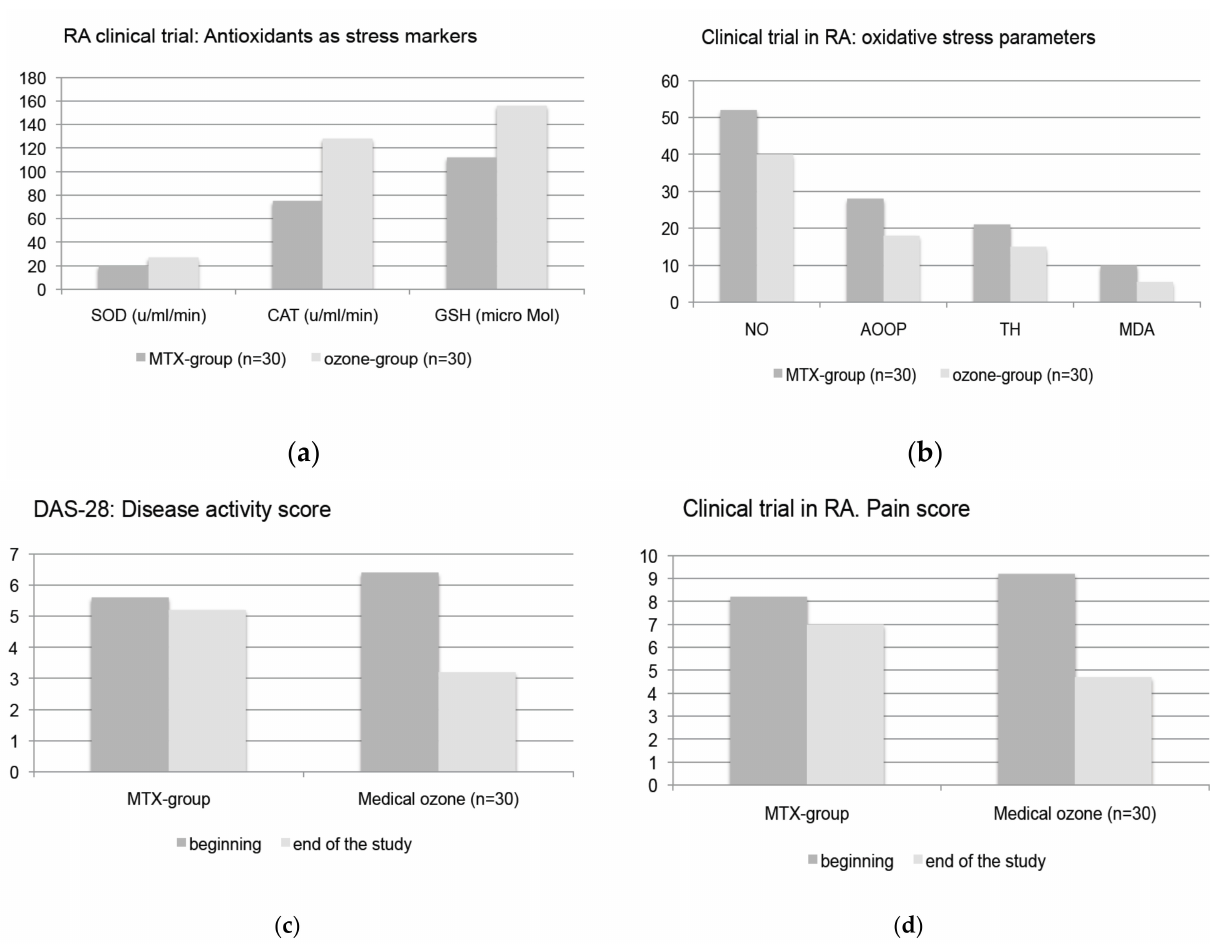
Figure 10. ( a ) Clinical trial in Rheumatoid arthritis RA ( n = 60) following 20 rectal ozone insufflations with ozone conc.: 25–40 µ g/mL and 5000–8000 µ g per treatment during 4 weeks. MTX-group ( n = 30): basic therapy MTX+Ibuprophen+Folic acid. Ozone-group ( n = 30): basics as MTX-group plus ozone rectally. SOD: superoxide dismutase, CAT: catalase, GSH: reduced glutathione [26]. ( b ). Oxidative stress markers NO: nitrogen monoxide ( µ Mol), AOOP: advanced oxidated proteins ( µ Mol), TH: total hydroperoxide ( µ Mol), MDA: malondialdehyde ( µ Mol) [26]. ( c ). Disease activity score following the EUROPEAN LEAGE AGAINST RHEUMATISM in patients with rheumatoid arthritis treated with standard therapy (MTX- group, n = 30) and standard therapy plus rectal ozone insufflation ( n = 30). DAS-28: low activity y ≤ 3.2; moderate activity Figure 10a) and ozone group ( n = 30) with standard therapy plus ozone at the beginning and at the end of the trial after 20 rectal insufflations